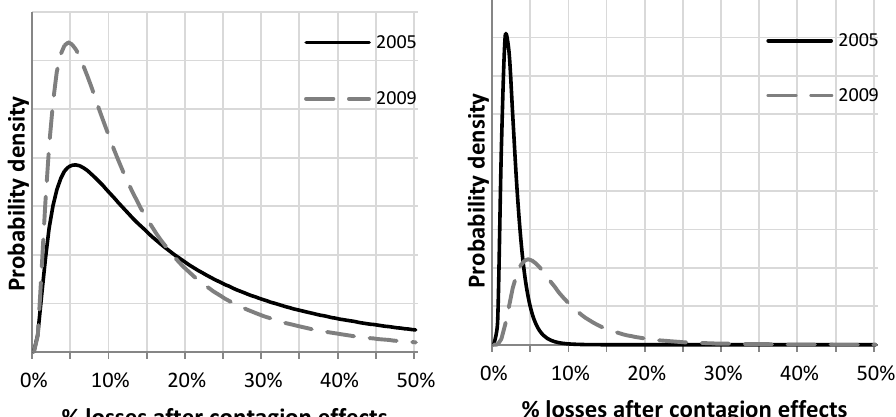
FIGURE 11 (left) and 12 (right): SA and UK buffer losses for buffer restoration models after contagion effects